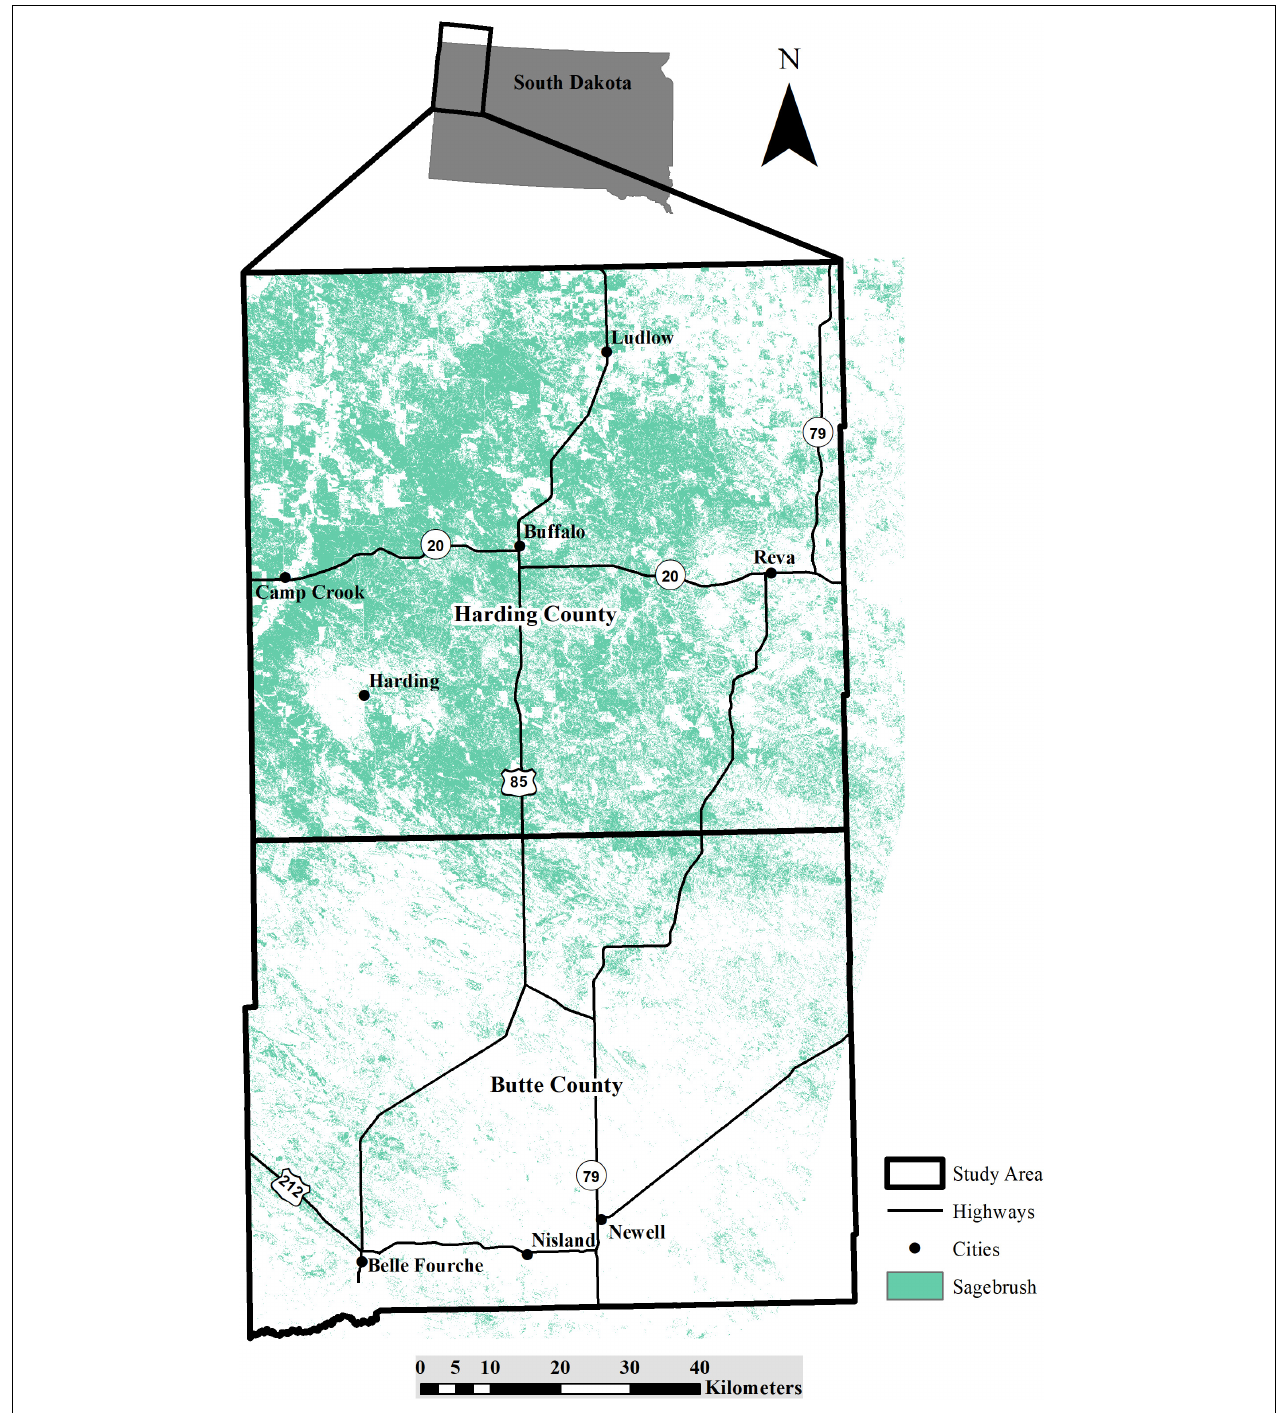
FIGURE 1 | Study area in Butte and Harding counties, South Dakota with major highways and sagebrush